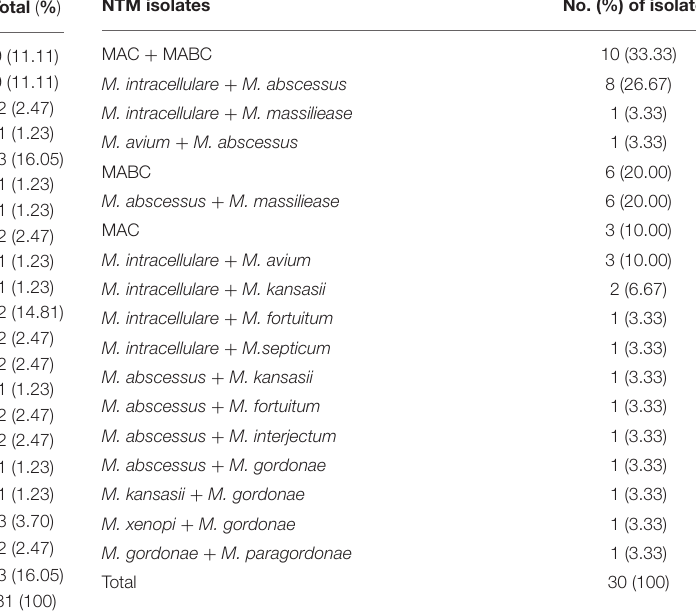
TABLE 4 | Non-mycobacteria pathogens identified from respiratory specimens in China, 2014–2021. Genus